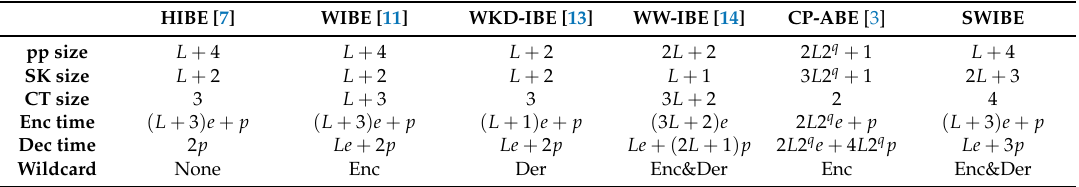
Table 1. Comparison of parameters between related works. ref. e = scalar multiplication, p = pairing, and L = hierarchy depth, q = ID bits, size indicates group elements, Enc = Encryption, and Der = Key